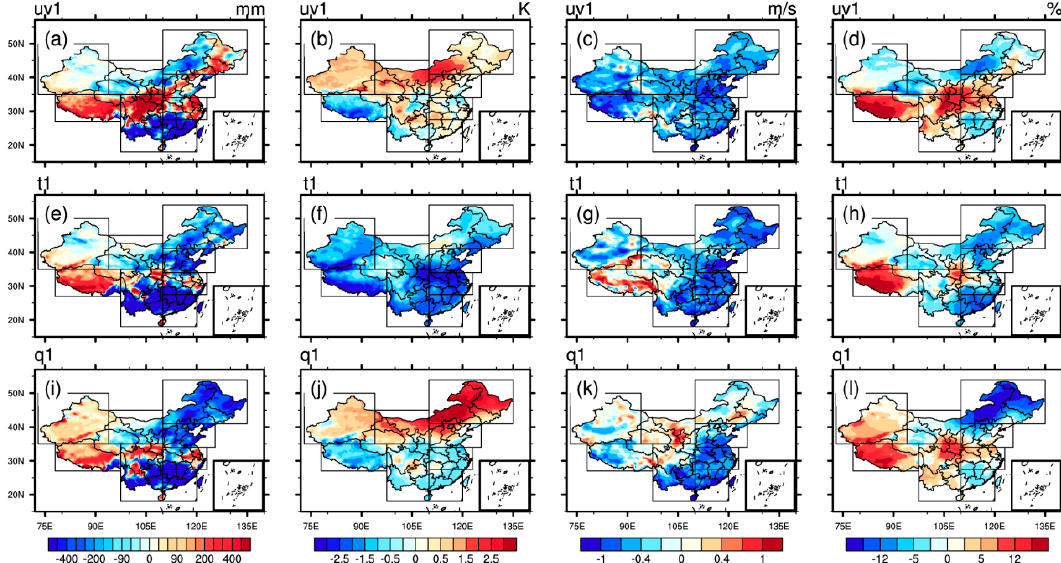
Figure 2. Difference of simulated near-surface meteorological elements with and without nudging in summer 2010: ( a – d ) simulated precipitation, temperature, wind speed, and relative humidity, respectively with nudging uv; ( e – h ) same as a – d , but nudging θ ; and ( i – l ) same as a – d , but nudging q.